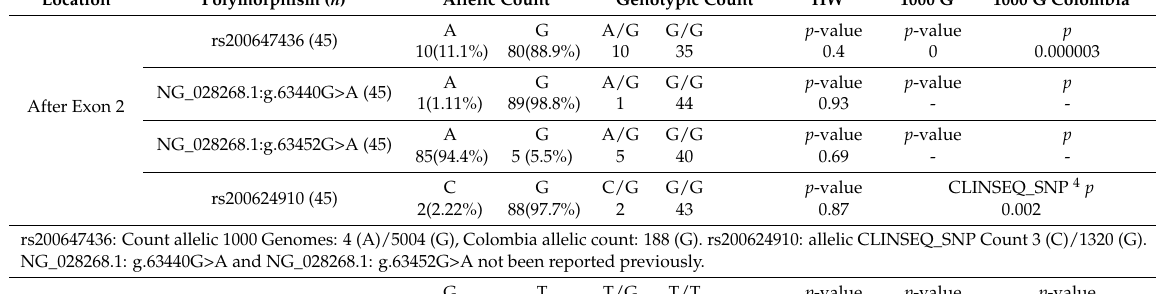
Table 3. The polymorphism ABCC1 ATP-binding cassette, sub-family C (Cystic Fibrosis Transmembrane Conductance Regulator (CFTR)/MRP), member